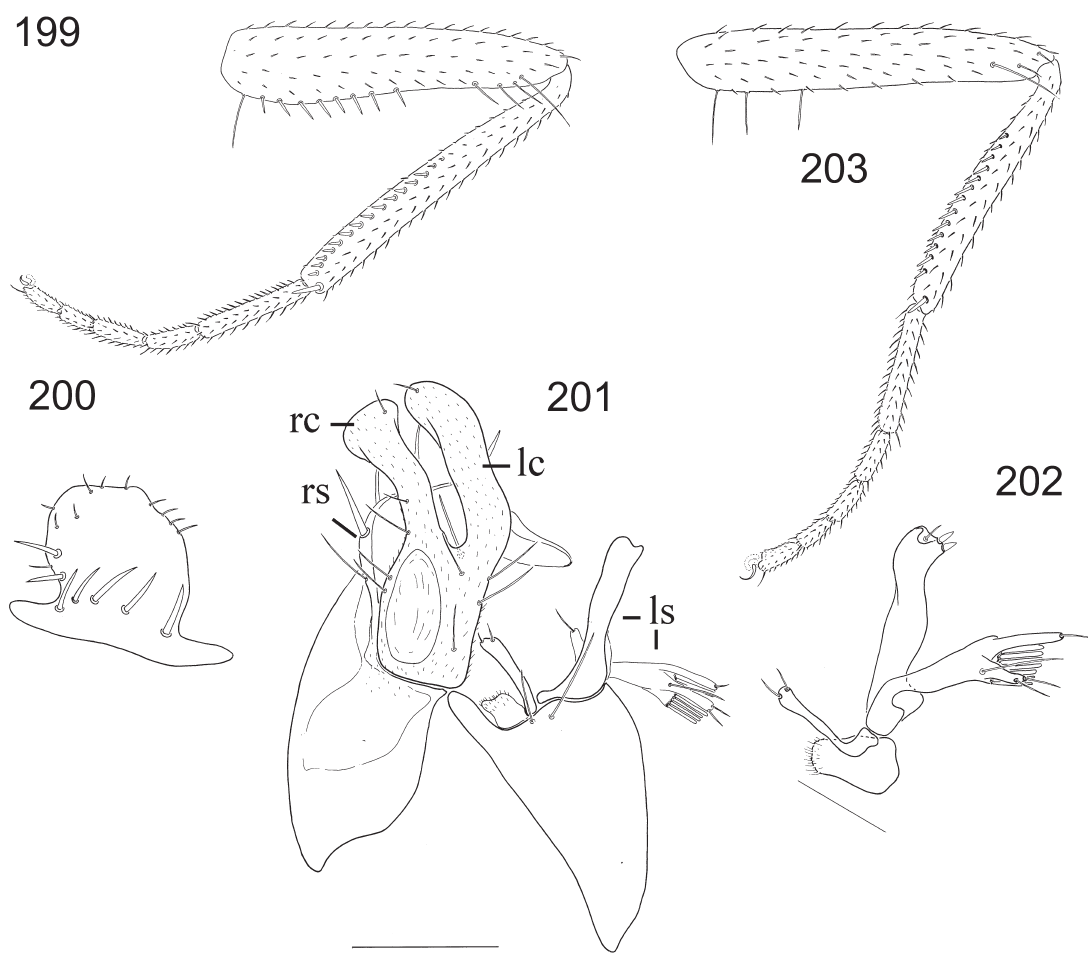
Figs 199-203. Stilpon , ♂. 199-202 . S. angkorensis Shamshev & Grootaert, 2006. 199 . mid leg, lateral view. 200 . right surstylus, dorsal view. 201 . epandrium with cerci, dorsal view. 202 . left surstylus, lateral view. 203 . S. goesi Shamshev & Grootaert, 2006, mid leg, anterior view. (after Shamshev & Grootaert